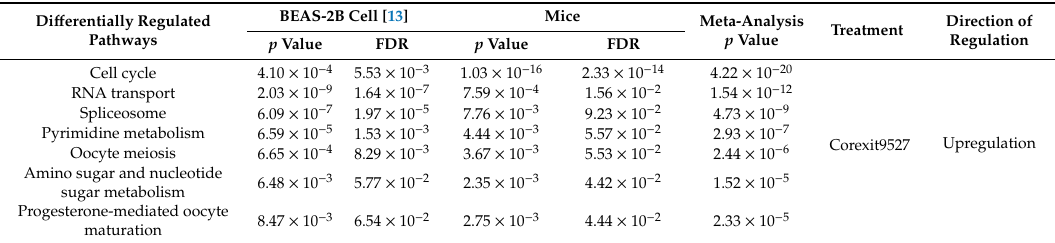
Table 5. Comparison between this study and RNA-seq analyses of a treated human airway epithelial cell line (BEAS-2B) [14] at pathway level.